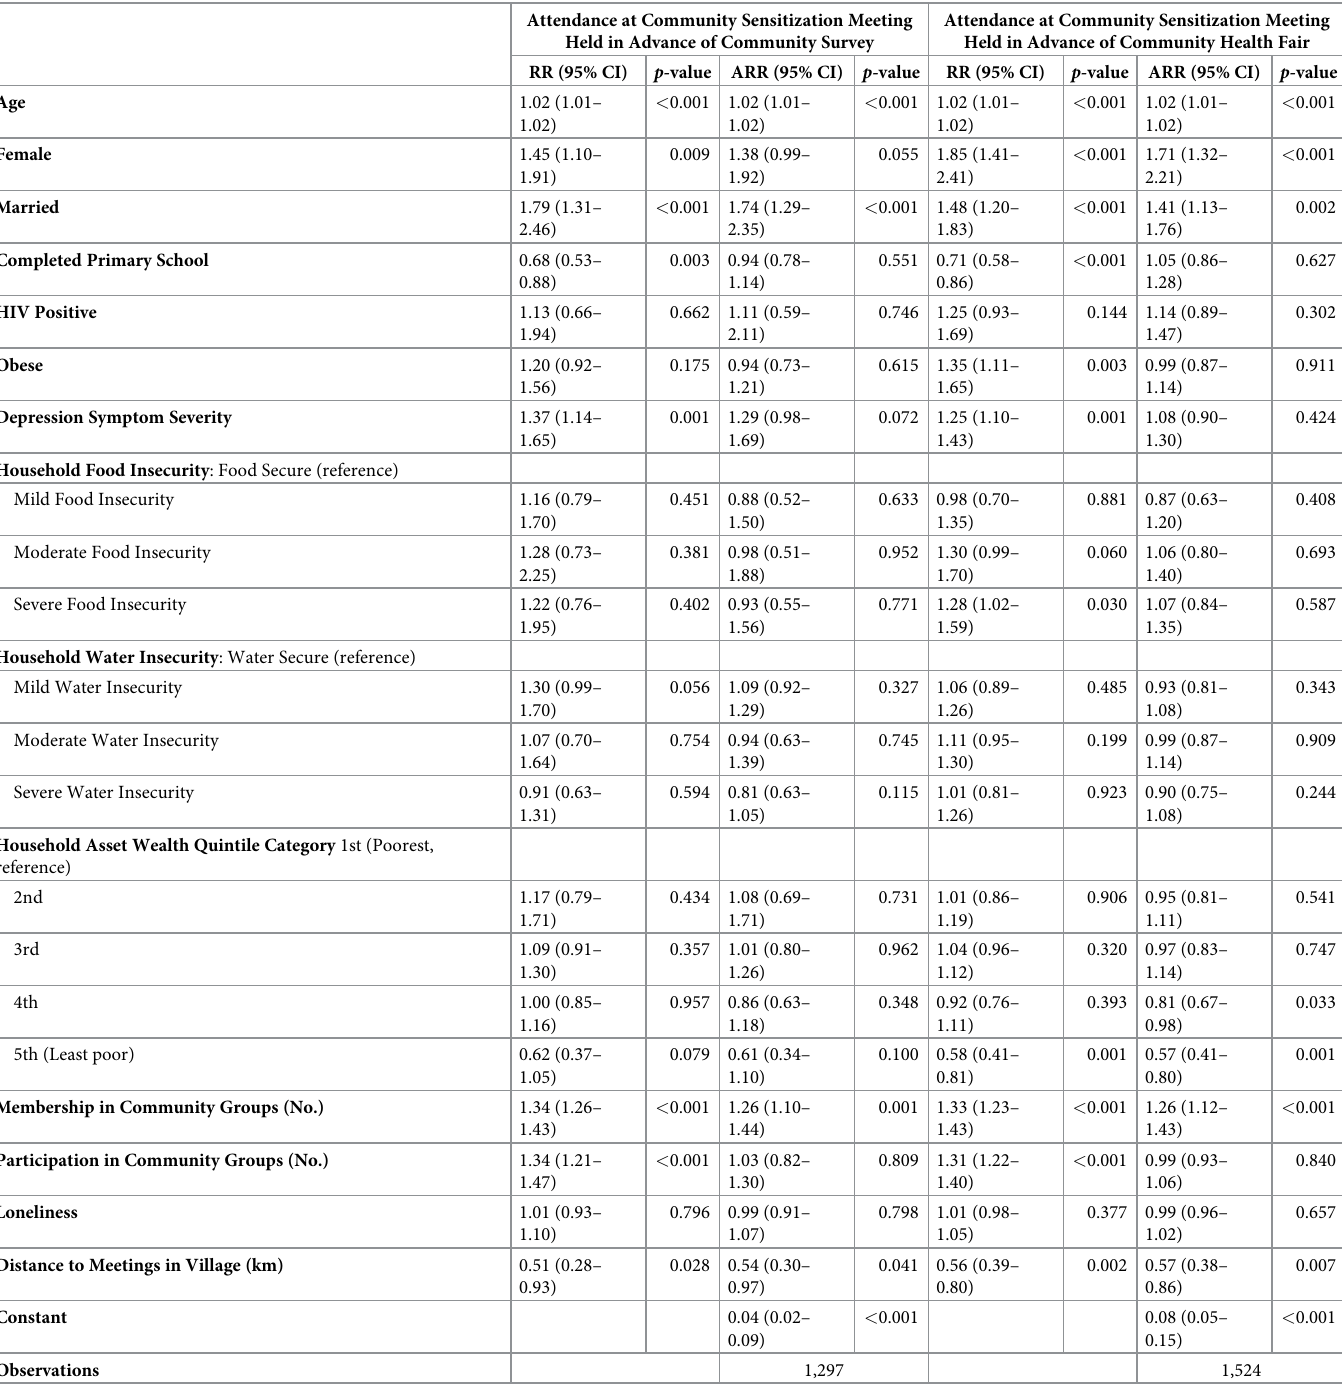
Table 3. Unadjusted and multivariable Poisson regression models estimating correlates of attendance at community sensitization meetings. Attendance at Community Sensitization Meeting Held in Advance of Community